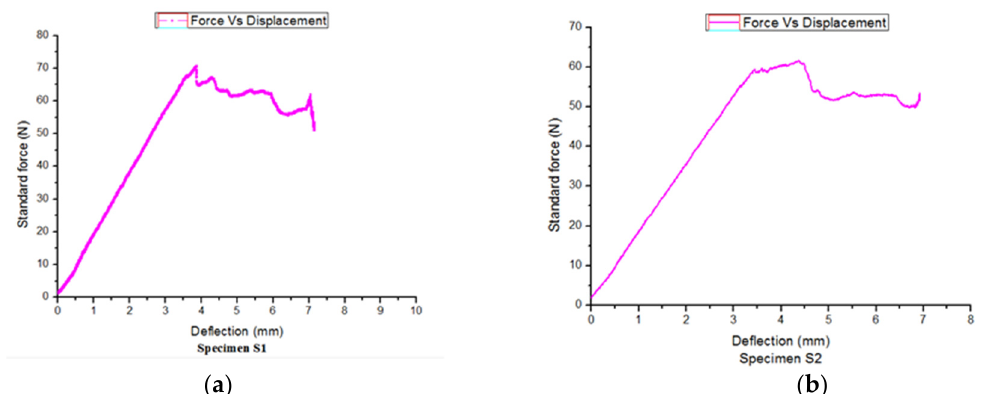
Figure 7. Flexural testing plots of test specimens: ( a ) Sample 1, ( b ) Sample 2. Table 4. Flexural modulus, flexural strength, and Elongation.